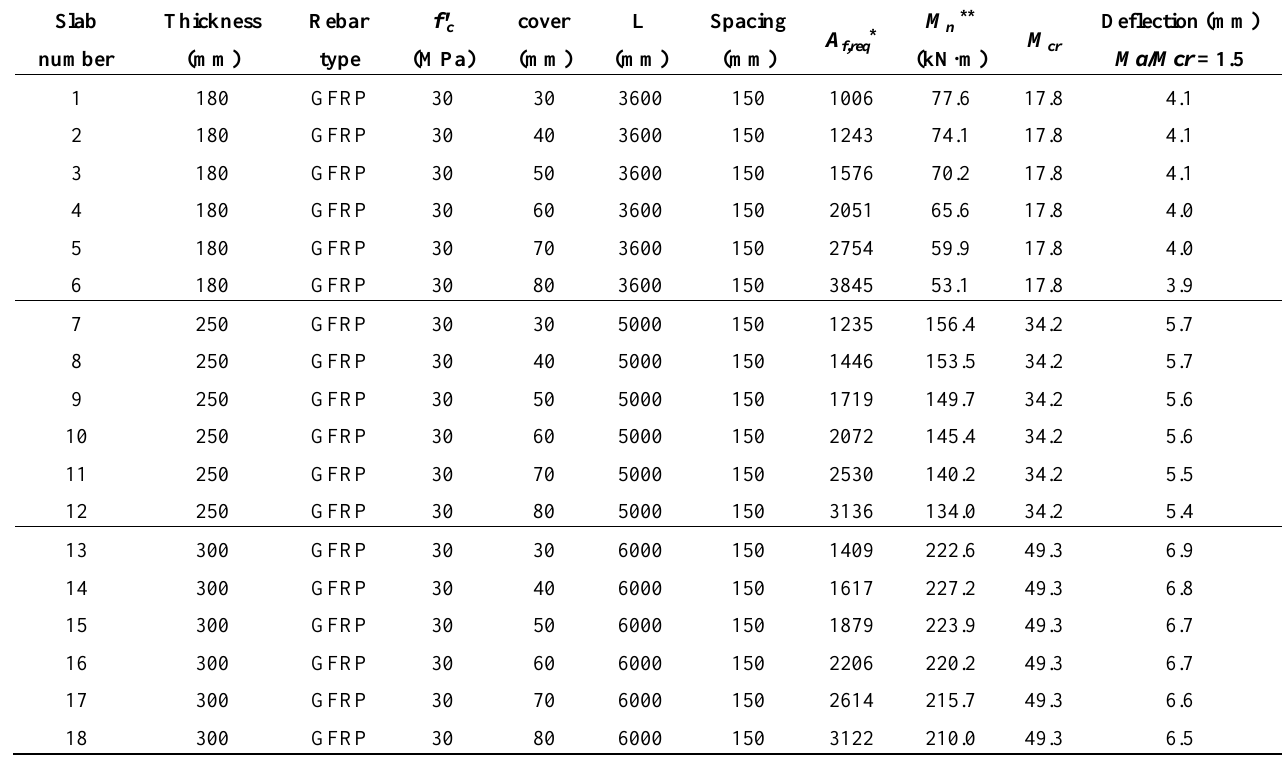
Table 1. Characteristics of FRP reinforced slabs investigated in this